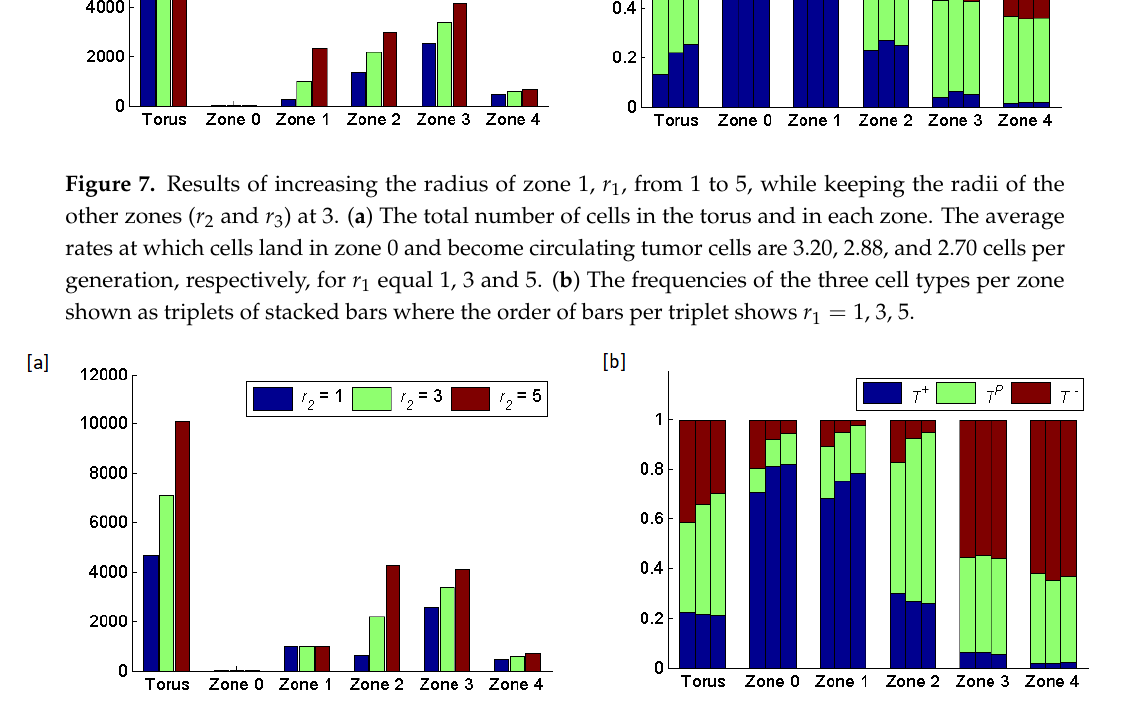
Figure 8. Results of increasing the radius of zone 2, r 2 , from 1 to 5, while keeping the radii of the other zones ( r 1 and r 3 ) at 3. ( a ) The total number of cells in the torus and in each zone. The average rates at which cells land in zone 0 and become circulating tumor cells are 3.04, 2.88, and 2.93 cells per generation, respectively, for r 2 equal 1, 3 and 5. ( b ) The frequencies of the three cell types per zone shown as triplets of stacked bars where the order of bars per triplet shows r 2 = 1,3,5 from left to the